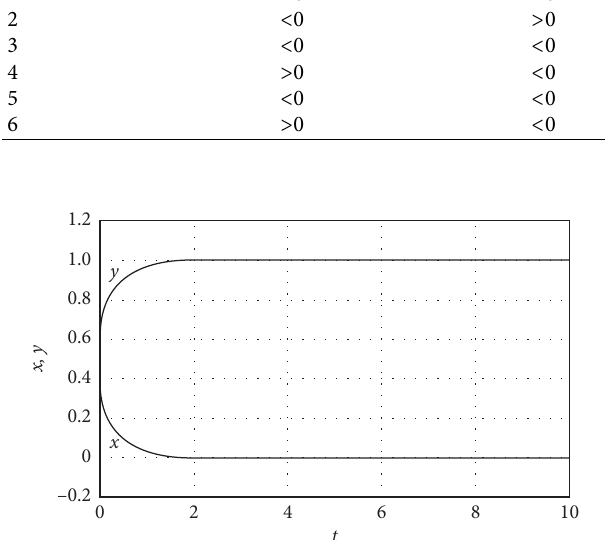
Figure 1: Dynamic evolution of government and enterprise strategy ( a